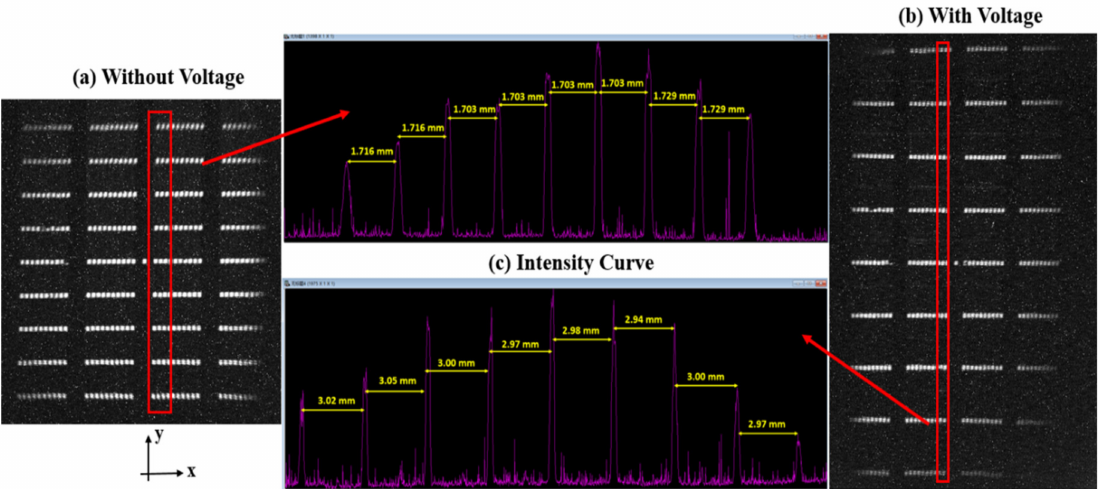
Figure 8. Test results: ( a ) the image obtained when the separator is not powered on; ( b ) the image obtained when the separator is powered on; ( c ) the distribution of the average value of intensity along the horizontal direction of the selected part in the red box in images ( a , b ) (the abscissa is the pixel position, and the ordinate is the intensity value).